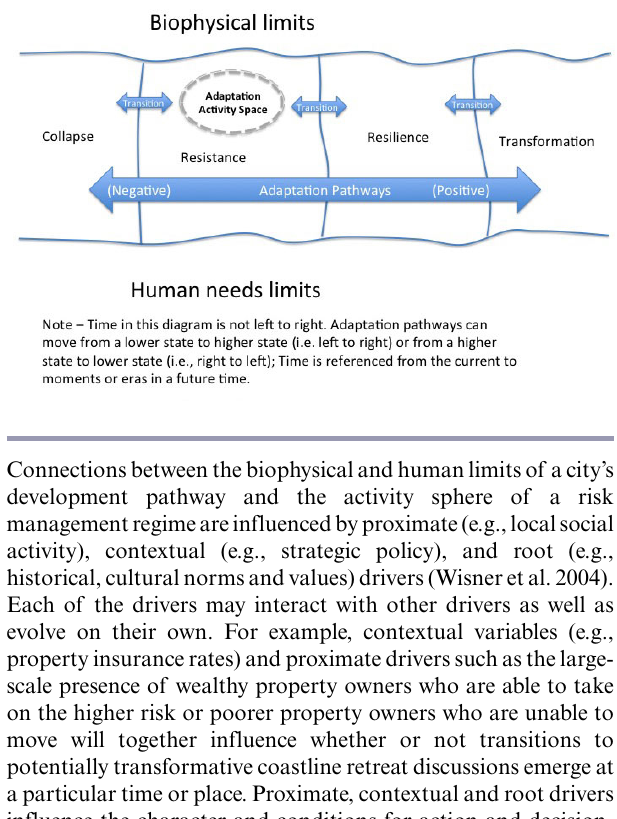
Fig. 2 . Adaptation pathways and the adaptation activity sphere located within the resistance risk management